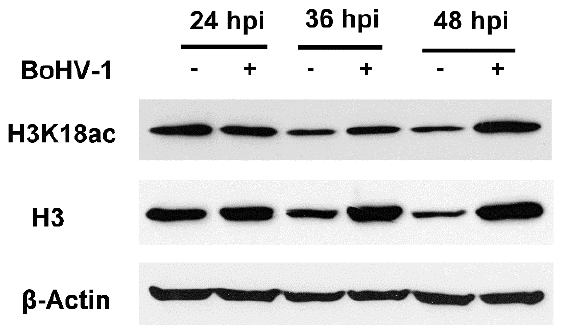
Figure 2. The effects of BoHV-1 infection had on the protein levels of H3K18ac. A549 cells in 60 mm dishes were mock infected or infected with BoHV-1 at a MOI of 1 for 24, 36 and 48 h. The cell lysates were then prepared for Western blot to detect the protein levels of H3K18ac and H3. Data shown are representative of two independent experiments.